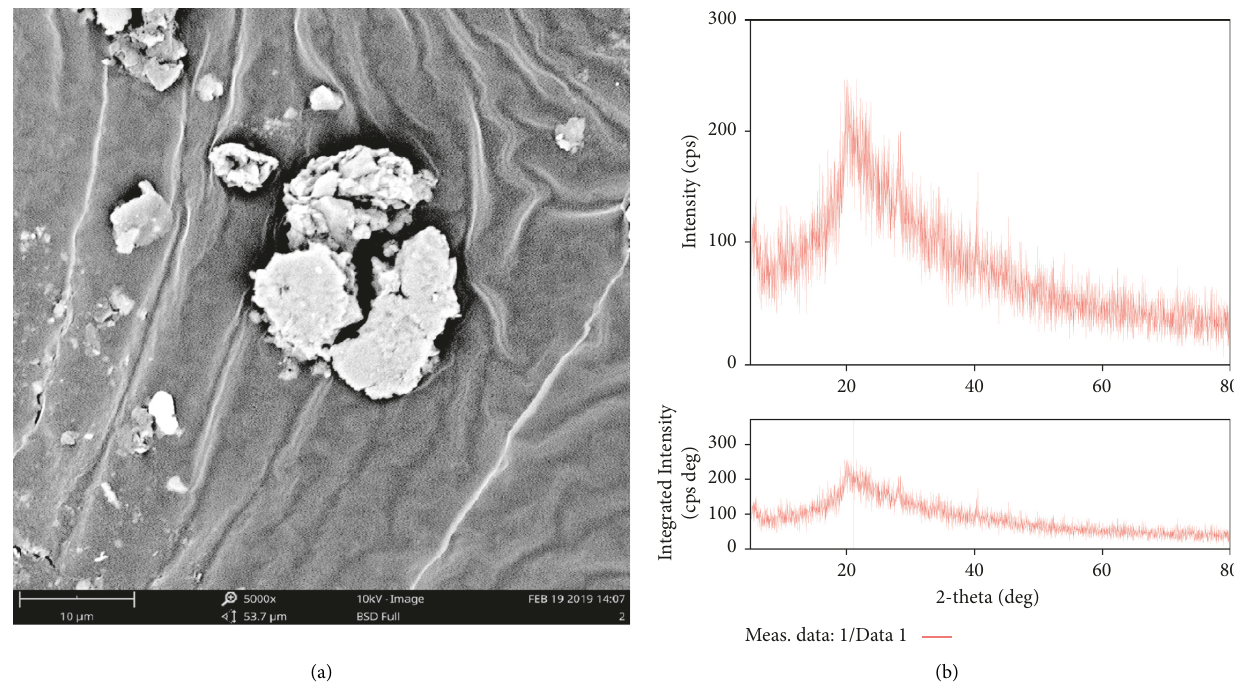
Figure 3: (a) SEM Image of the raw effluent. (b) XRD Spectrum of the raw effluent.